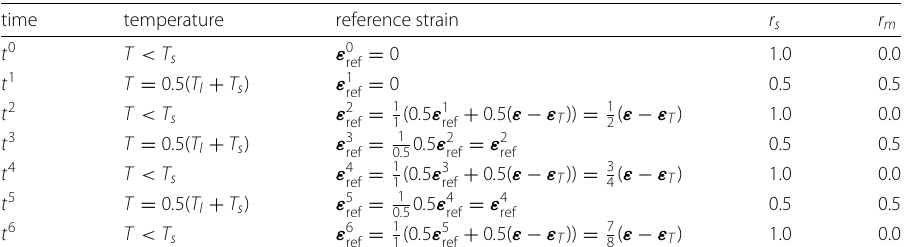
Table 4 Exemplary evolution of reference strain for a cyclic, partial remelting of solid phase assuming ε − ε T is constant in all phase change intervals time temperature reference strain r s r m t 0 T < T s ε 0 = 0 1.0 ref